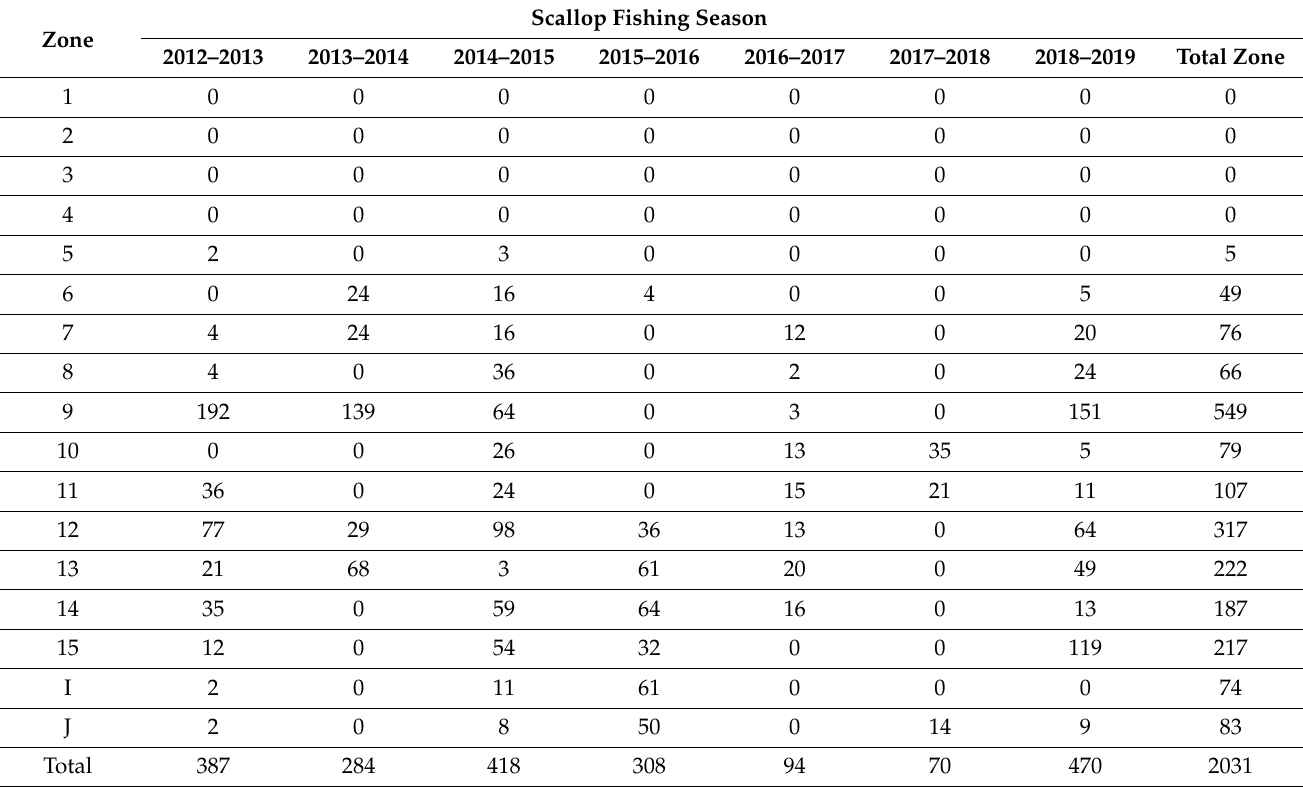
Table 1. Closures of scallop fishing areas (duration in days). Source: